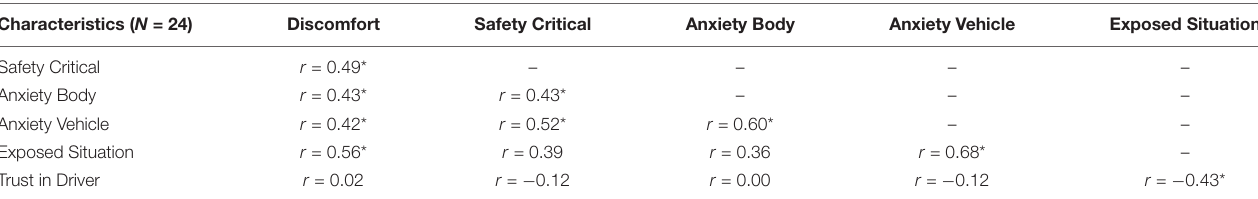
FIGURE 3 | Situational conditions of the three areas and ratings regarding their influence on the discomfort (left). The four participants which named reasons of the area environment and vehicle and all situational conditions which were rated by more than 75% of the participants as “not influential” (rating = 0) are not presented in the graph. Rated characteristics of their last uncomfortable situations (right). TABLE 4 | Pearson correlations of characteristics of uncomfortable situations.